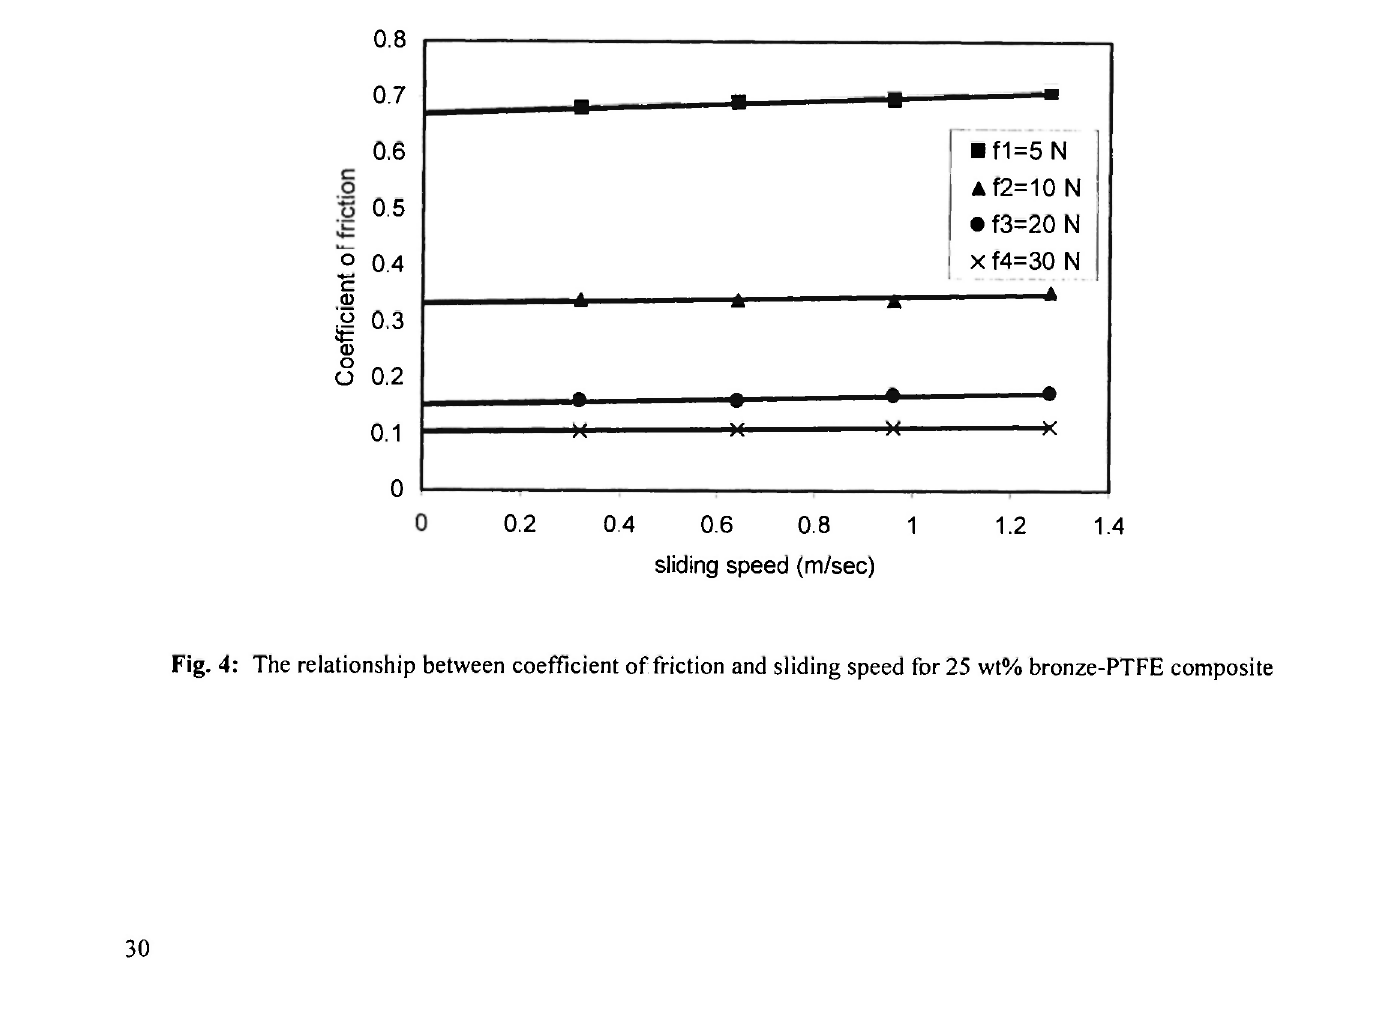
Fig. 3: The relationship between coefficient of friction and sliding time for 25 wt% bronze-PTFE composite